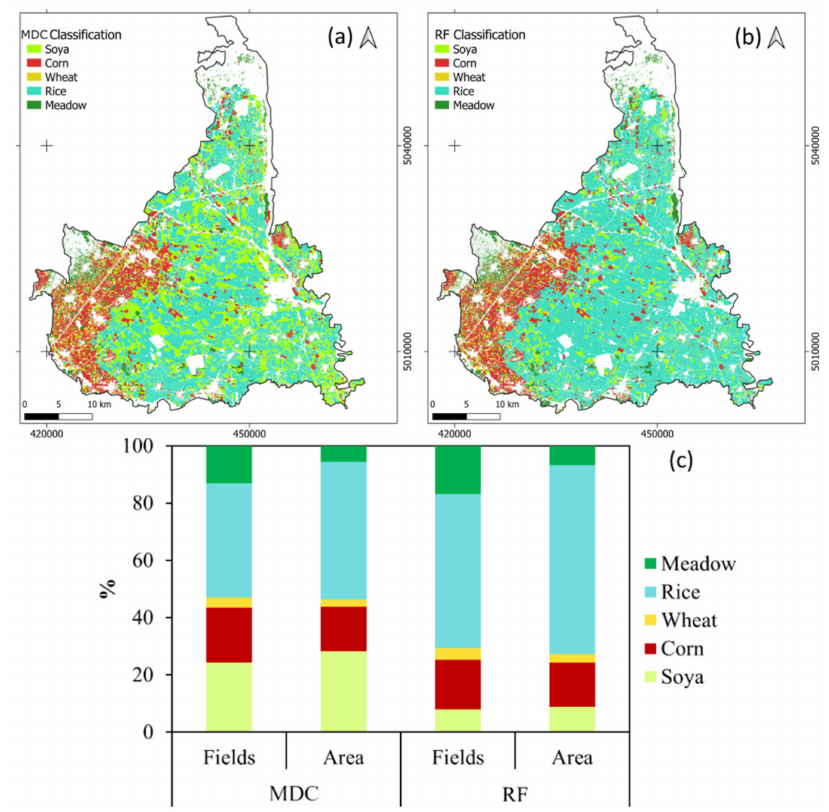
Figure 5. ( a ) MDC classification map. ( b ) RF classification map. ( c ) Fields (%) and surface (%) monitored for each crop in MDC and RF classification (reference system is WGS84/UTM 32N, EPSG: 32632).